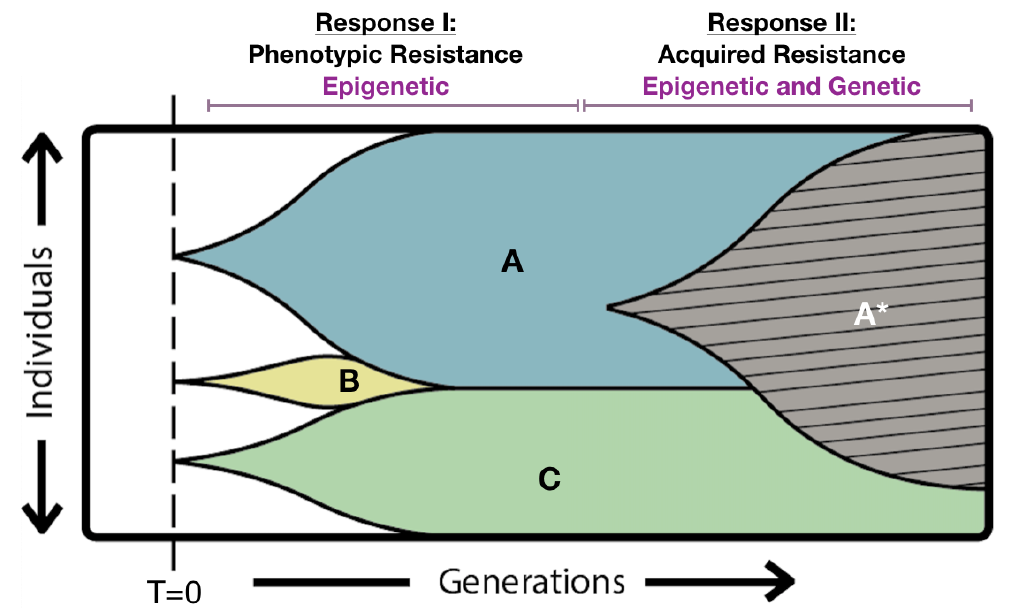
Figure 2. Theoretical epigenetic and genetic combination model to explain Candida spp. growth in the presence of high concentrations of anti-fungal drug. The diagram shows the epigenotype and genotype of an evolving population of Candida yeast cells when exposed to an antifungal drug (concentration > MIC) at time 0 (T = 0). Three individual cells are capable of growing under these conditions and their descendants give rise to sub-populations A, B, and C. We postulate that this ability to grow is dictated by an advantageous epigenetic program within each of these cells either at the time of antifungal exposure, or very soon thereafter. We refer to this as response I, which accounts for the trailing growth phenotype typically seen 48 h after drug exposure. In this particular example, sub-population B is outcompeted by sub-populations A and C which presumably have greater relative adaptive fitness. After some time, a cell in sub-population A acquires a genetic lesion that confers anti-fungal resistance (A*), providing a selective advantage over its non-mutated ancestors, and the population as a whole has entered phase II, the acquired resistance phase. In the time period depicted, a fraction of descendants from the epigenetically defined, phenotypically resistant population C remain.